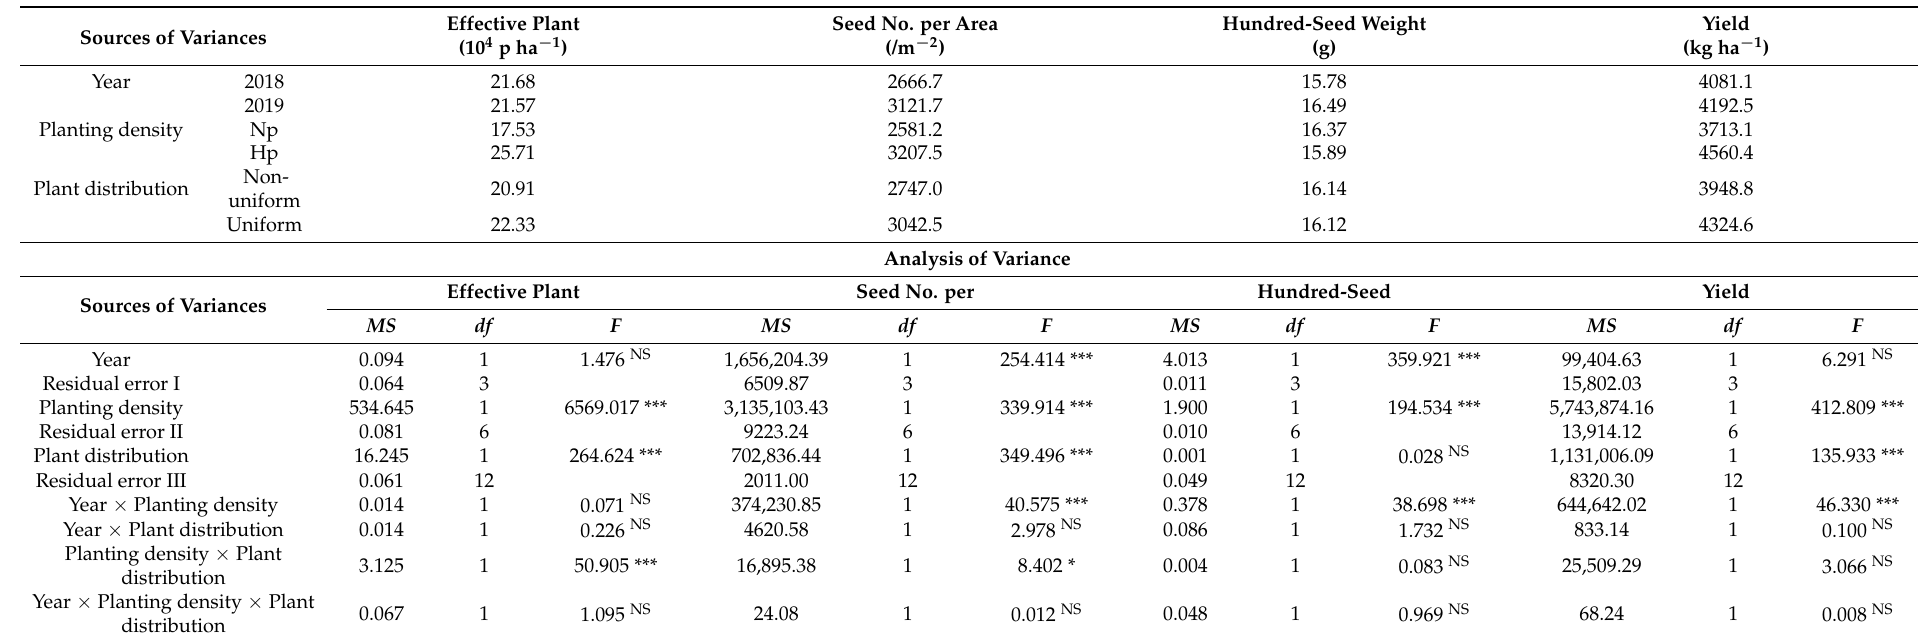
Table 1. Effect of plant distribution on yield and yield components of soybean under different planting